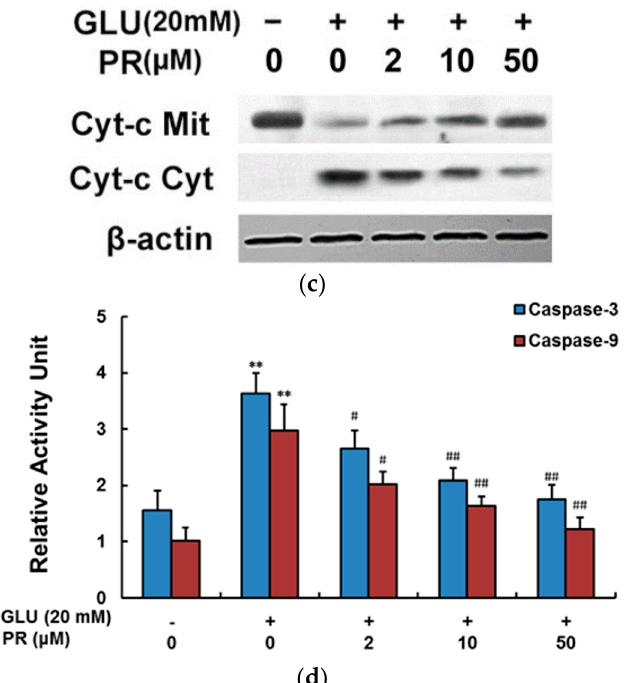
Figure 5. Puerarin attenuated glutamate-induced activation of mitochondrial-dependent signaling pathways. Cells were pre-treated with puerarin (0, 2, 10 and 50 μ M) for 24 h and then exposed to 20 mM glutamate for 24 h. ( a ) The expression levels of Bax and Bcl-2 were determined by western blot analysis; ( b ) fluorescence ratio was used for mitochondria membrane potential (MMP) quantitative analysis; ( c ) the levels of cyto and mito cytochrome c were detected by western blot analysis; ( d ) the activities of caspase-9 and caspase-3 were determined. All data were expressed as mean ± SD of three experiments and each experiment included triplicate repeats. ** p < 0.01 vs. control group; # p < 0.05, ## p < 0.01 vs. glutamate-treated group. GLU: glutamate, PR: puerarin.